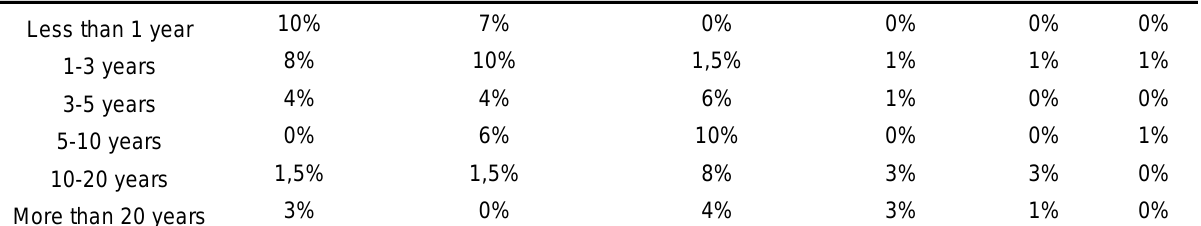
Table 4 - Comparison of work experience and